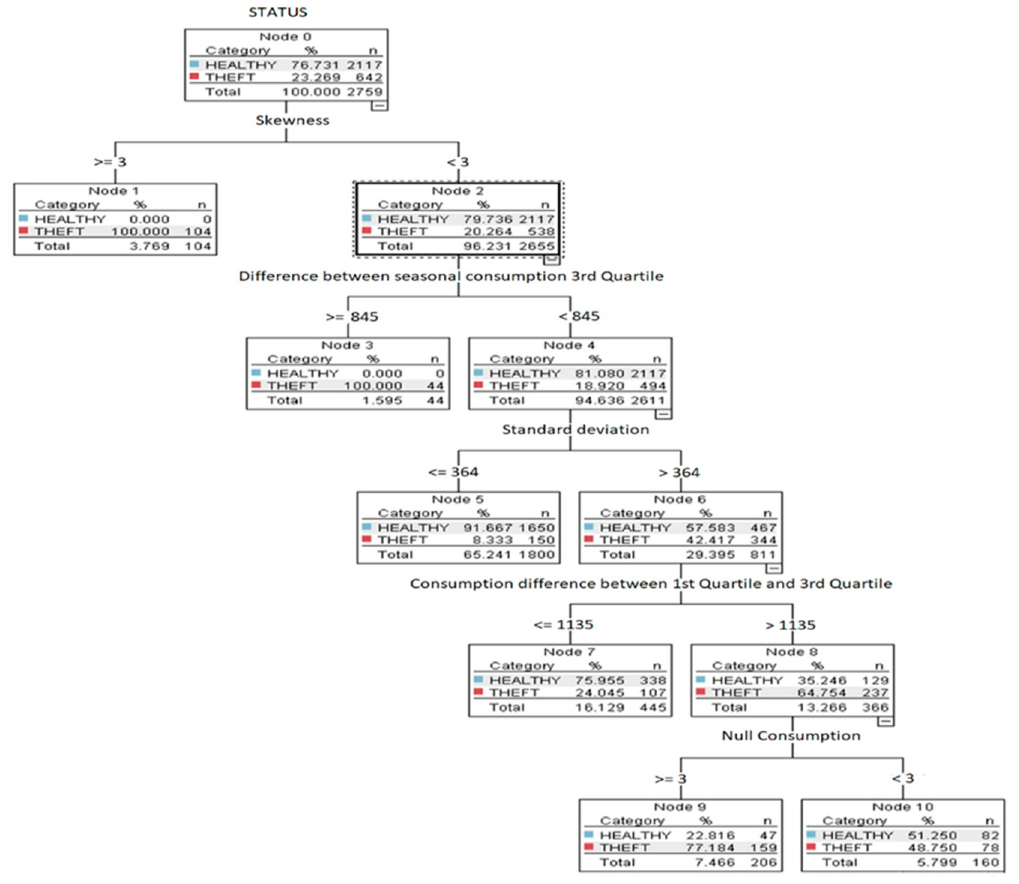
Figure 3. C.50 DT for NTL detection.